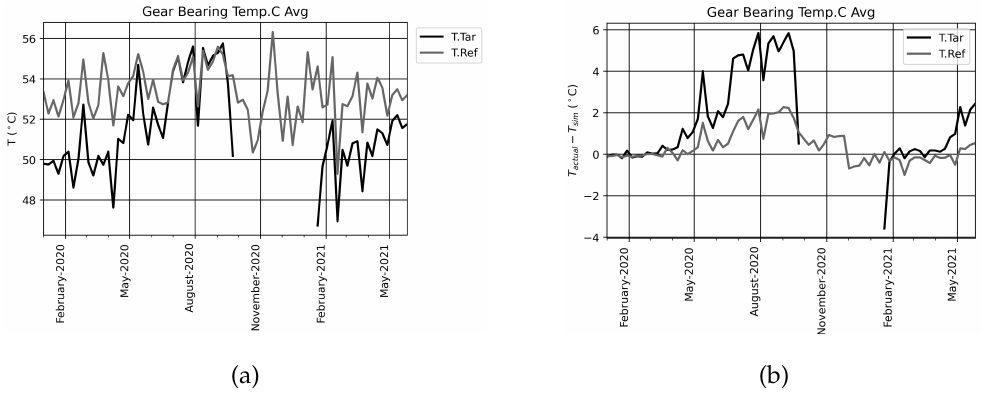
Figure 7. Gear bearing C temperature weekly average trend of raw data ( a ) and the error of the SVR model ( b ).